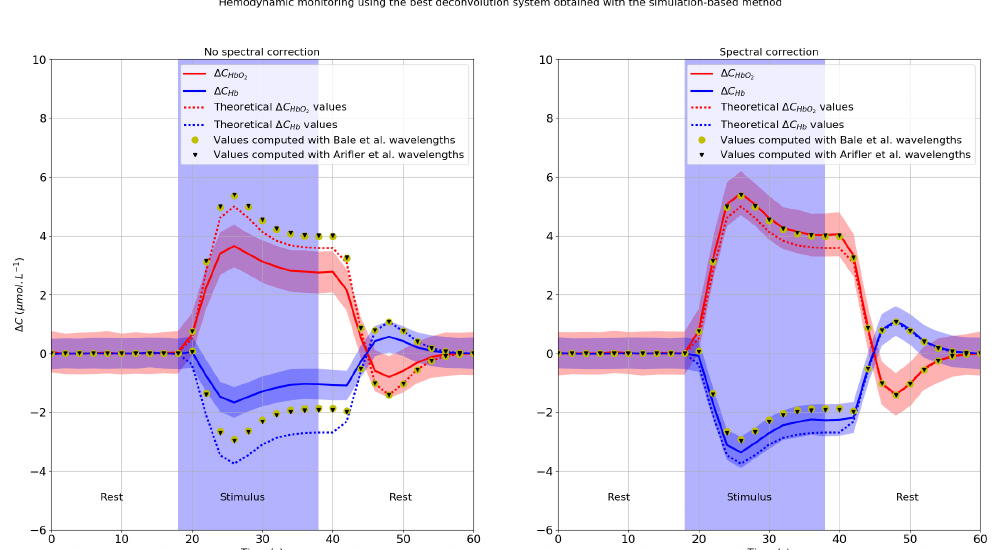
Figure 10. Hemodynamic monitoring following neuronal activation computed with the spectral configuration of the hyperspectral camera obtained with the simulation-based method (see Figure 7). The dashed lines represent the theoretical hemodynamic responses following the neuronal stimulation. The dispersion ranges of the measurements are represented by colored areas. The concentration changes averaged over the 10 3 noisy measurements are represented in solid lines. The concentration changes’ time courses computed with the 121 wavelengths included between 780 nm and 900 nm [23] are represented with yellow points. The ones computed with Arifler et al.’s wavelengths [27] are represented with black triangles. The blue rectangle represents the “patient” physiological